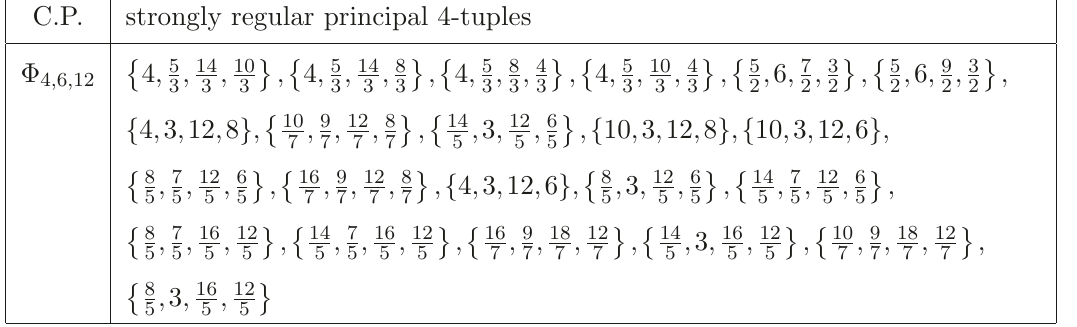
Table 11 . Strongly regular principal 4-tuples for rank